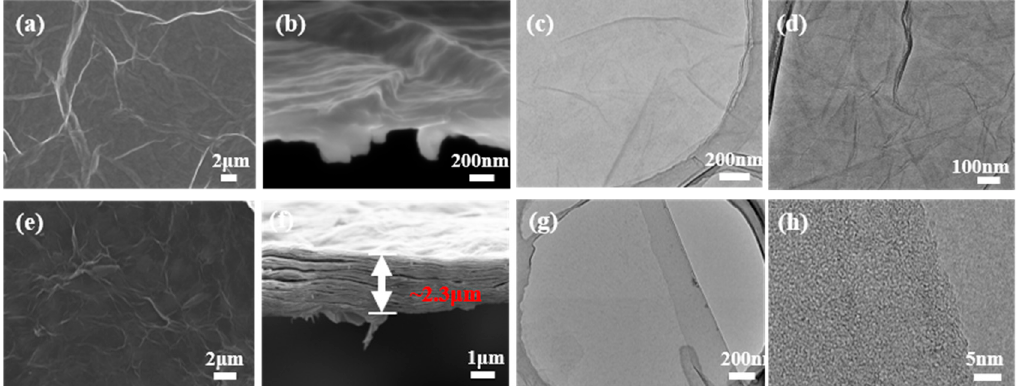
Figure 1. NMP dispersion of RGO before and after one month: ( a ) RGO EGM , ( b ) RGO NMP , and ( c ) redisperse RGO.